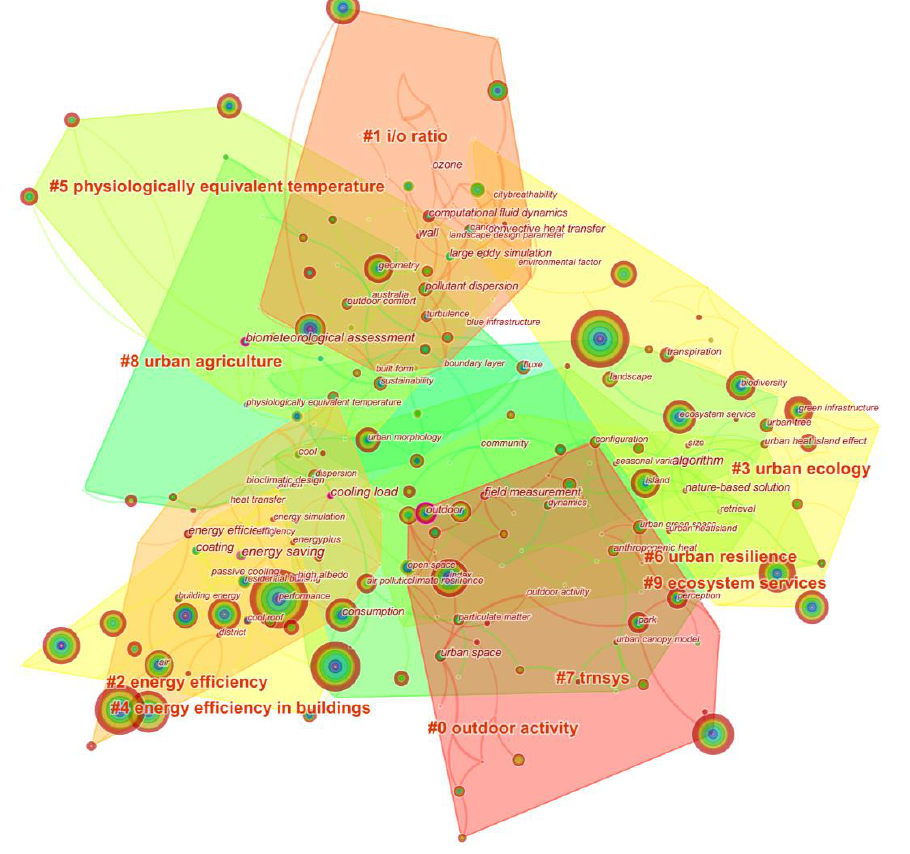
Table 5. Keyword clustering of RCHSCC in the last five years.